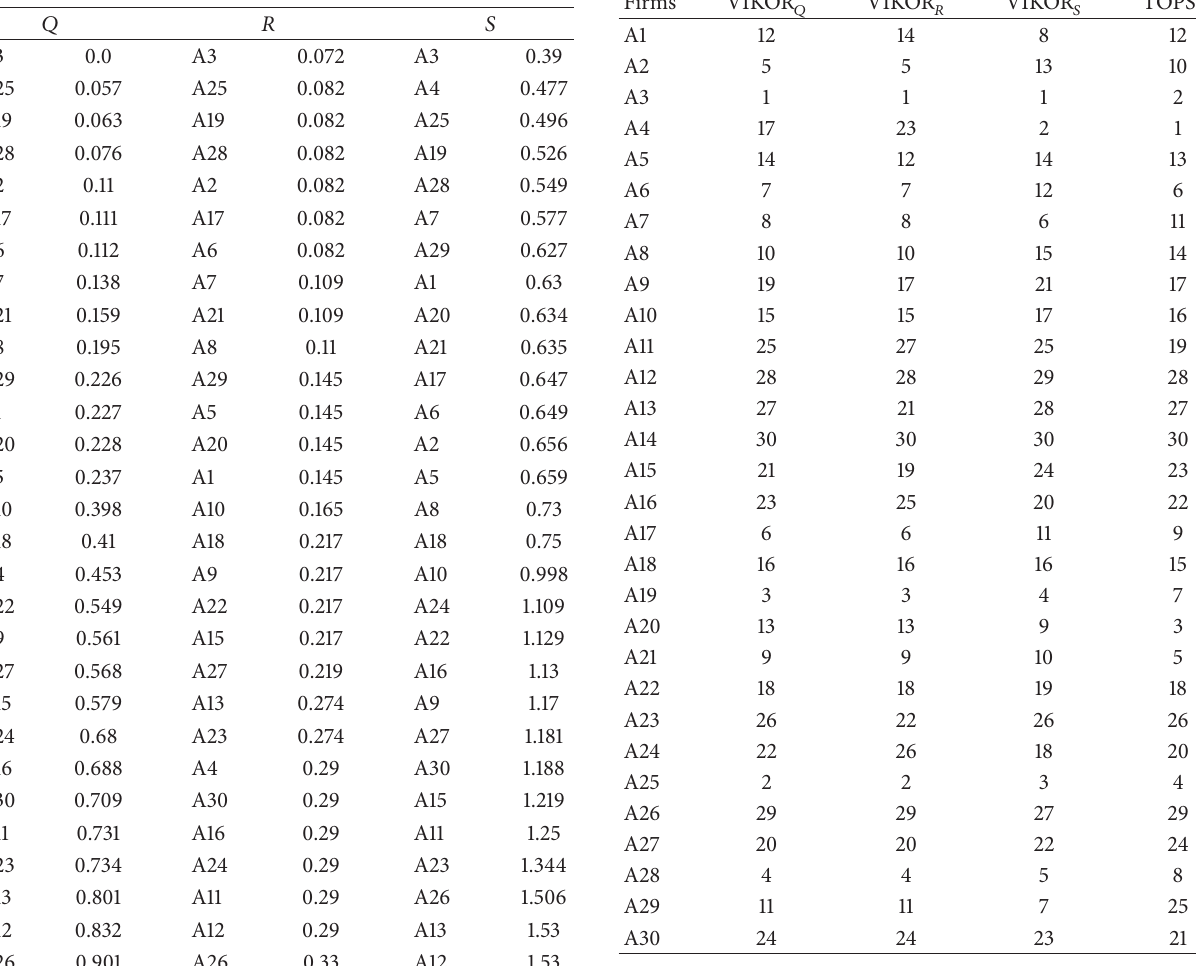
Table 9: The ranking of the firms by 𝑆 , 𝑅 , and 𝑄 in an ascending order.